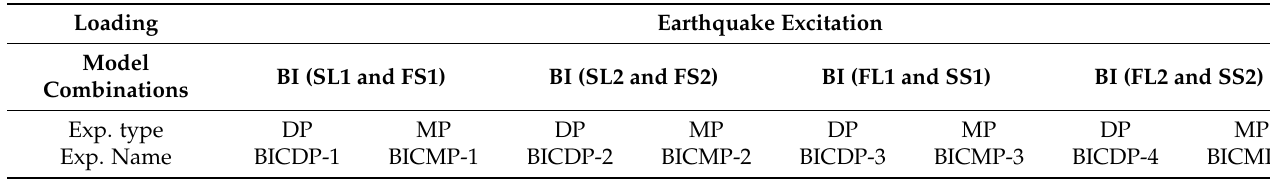
Table 5. Experiments of different frequency models.